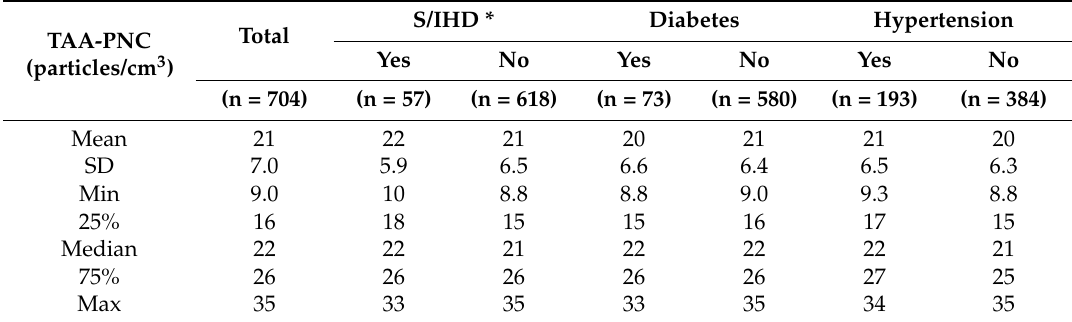
Table 2. Distribution of time-activity adjusted annual average particle number concentrations (10 3 particles · per · cm 3 ) exposure by health outcomes.